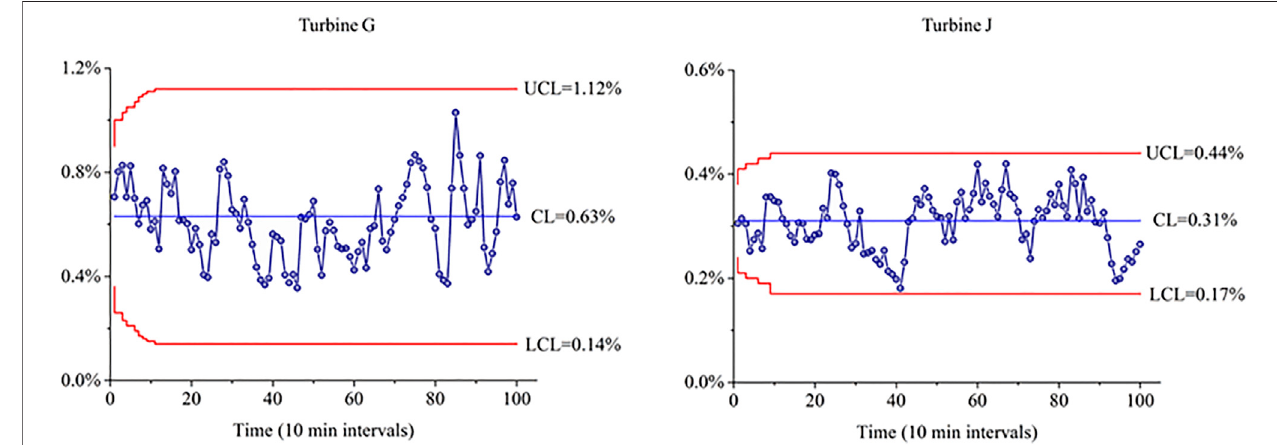
FIGURE 5 | The EWMA control charts of two healthy turbines.